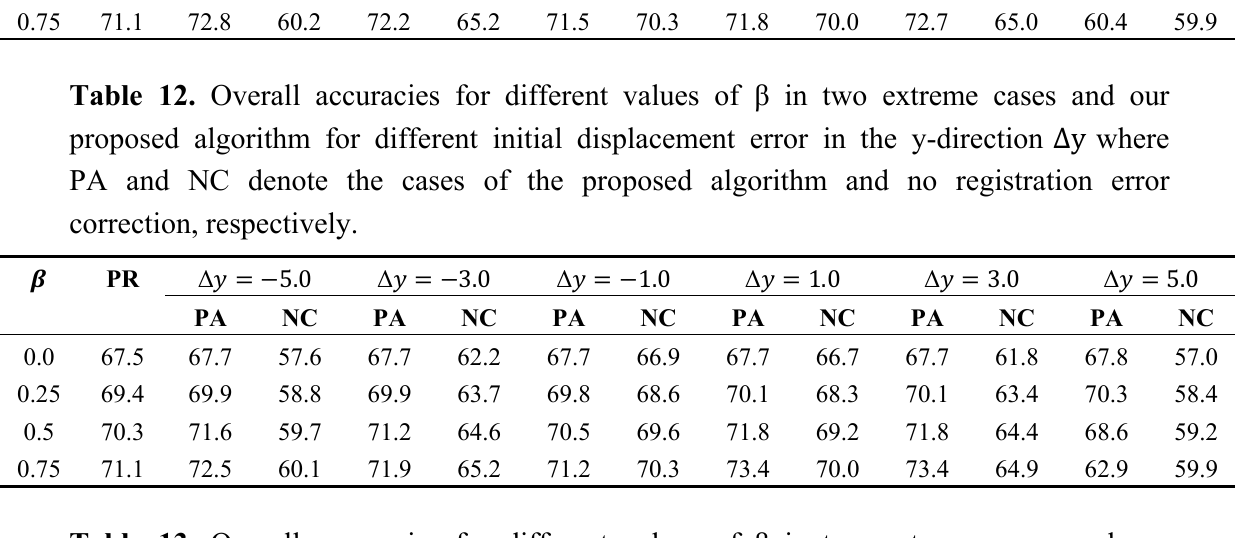
Table 13. Overall accuracies for different values of β in two extreme cases and our proposed algorithm for different initial scale error Δs where PA and NC denote the cases of the proposed algorithm and no registration error correction,